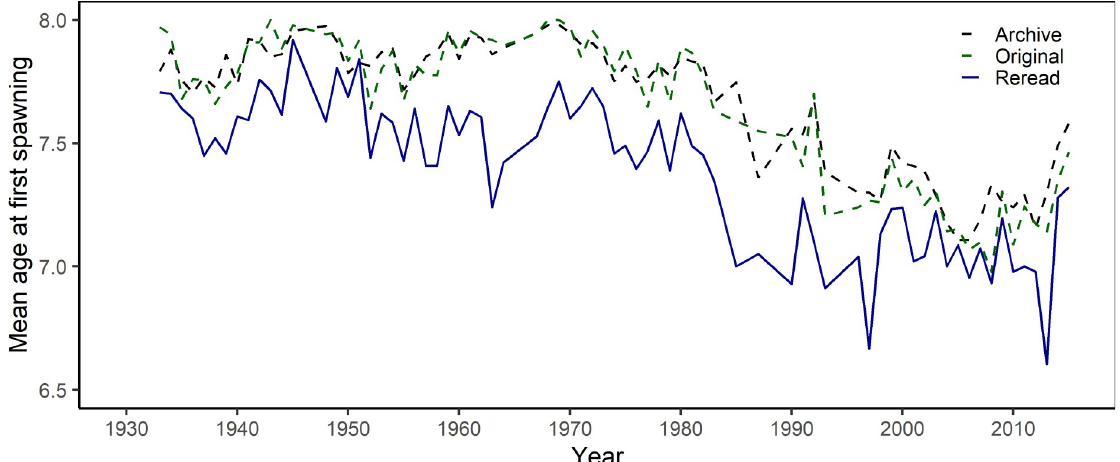
Fig 10. Comparison of changes in age at maturity between readings. Mean age at maturity of fish captured at age 8 calculated for each year between 1932 and 2015 from the entire archive (black dashed line), the original readings of our subsample (green dashed line) and the reinterpretation by a single contemporary reader (solid blue line).